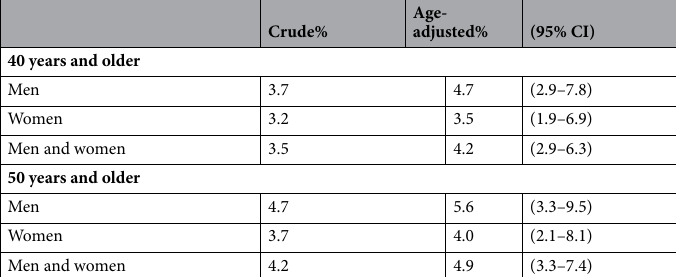
Table 1. Prevalence of retinal vascular events. CI confidence interval.